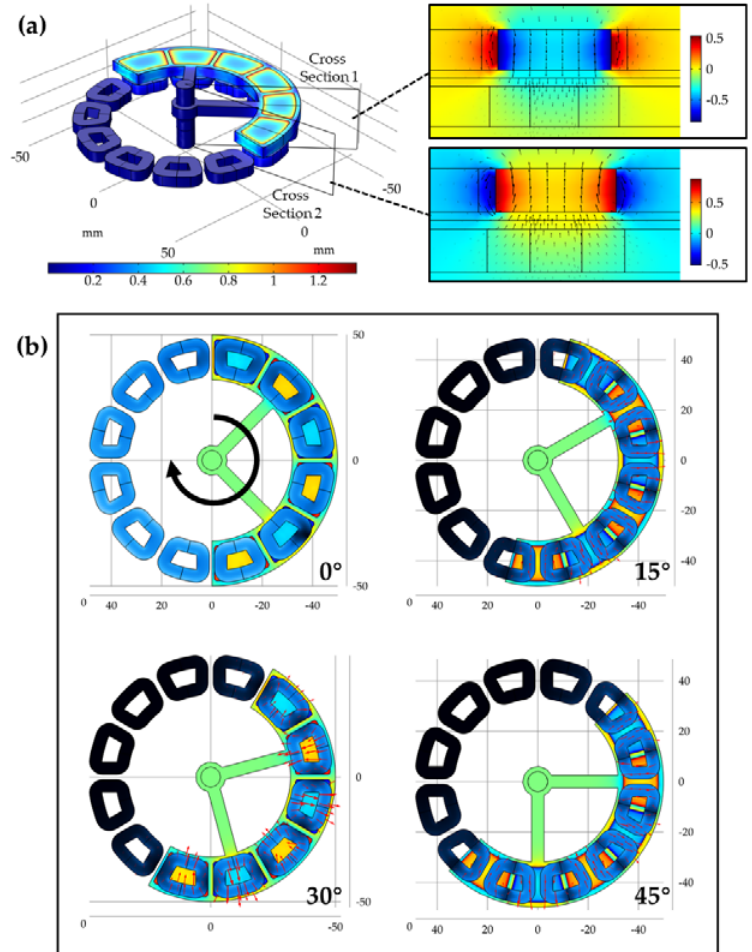
Figure 2. ( a ) Magnetic flux density distribution results; ( b ) the z-component of magnetic flux density distribution results on the cross-sections of the adjacent magnets.